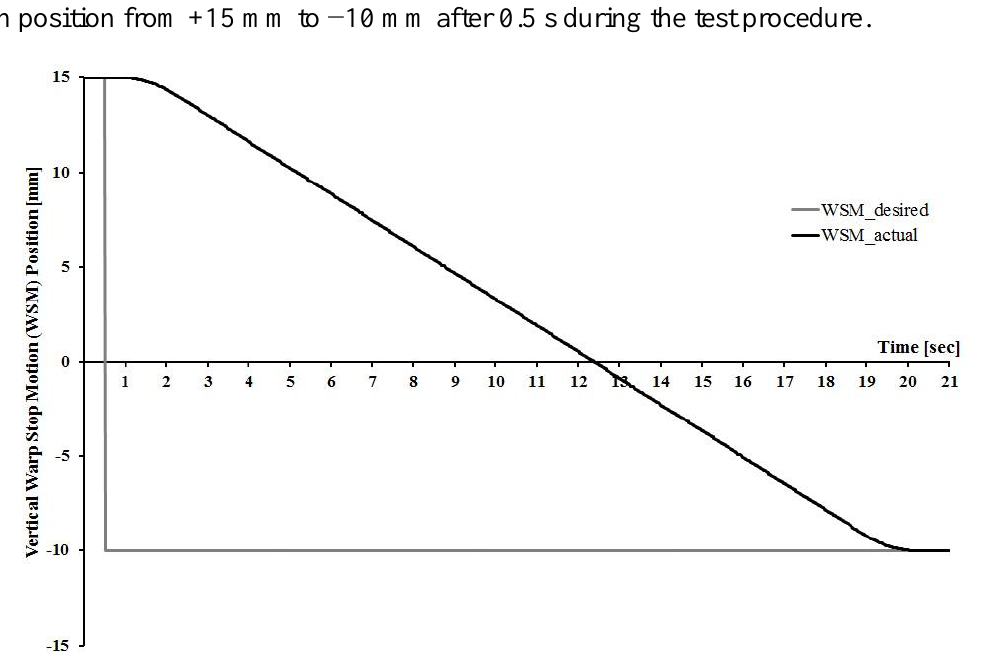
Figure 10. Desired and actual warp stop motion position during the test